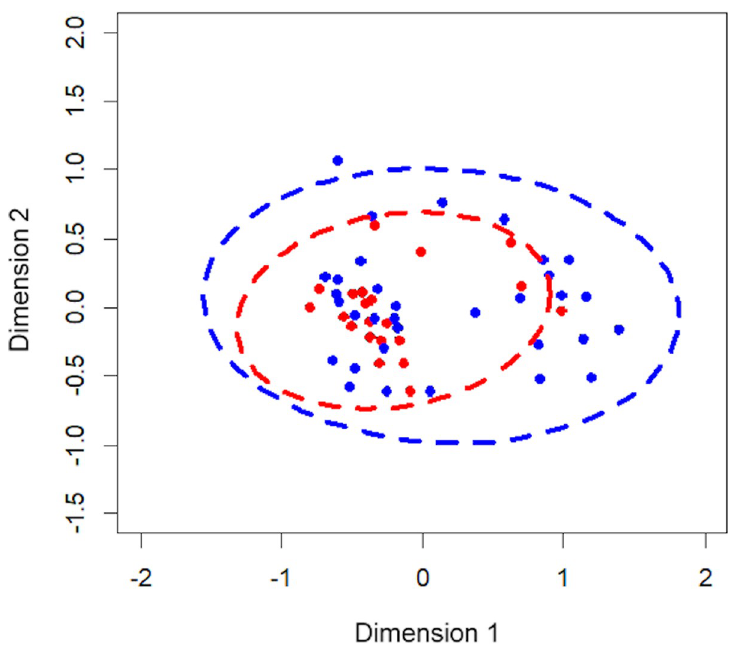
Fig 2. The Non-metric Multidimensional Scaling (NMDS) plot represented the bacterial composition of each patient, grouped by ICS dose; low-dose ICS (red) and high-dose ICS (blue). The shorter the distance between the dots, the more similar the bacterial compositions were between the